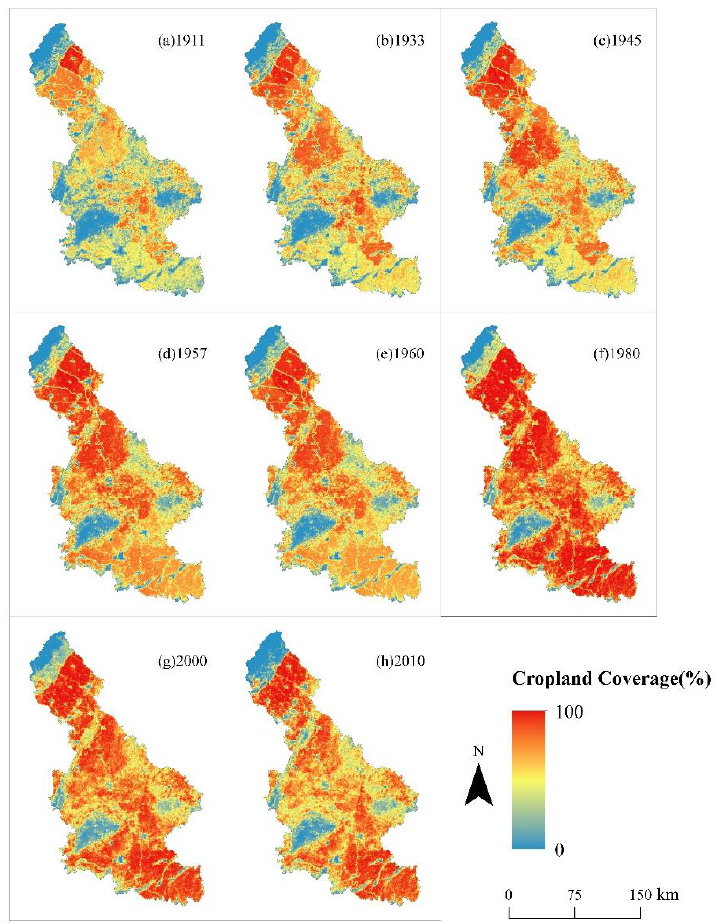
Figure 7. Cropland coverage changes in the Tuojiang River Basin in 1911, 1933, 1945, 1957, 1960, 1980, 2000, and 2010. 1957, ( e ) 1960, ( f ) 1980, ( g ) 2000, and ( h )